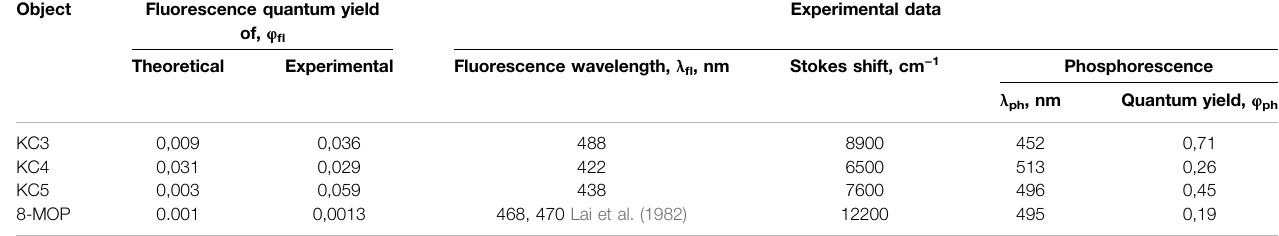
TABLE 2 | Luminescence quantum yields of the compounds.